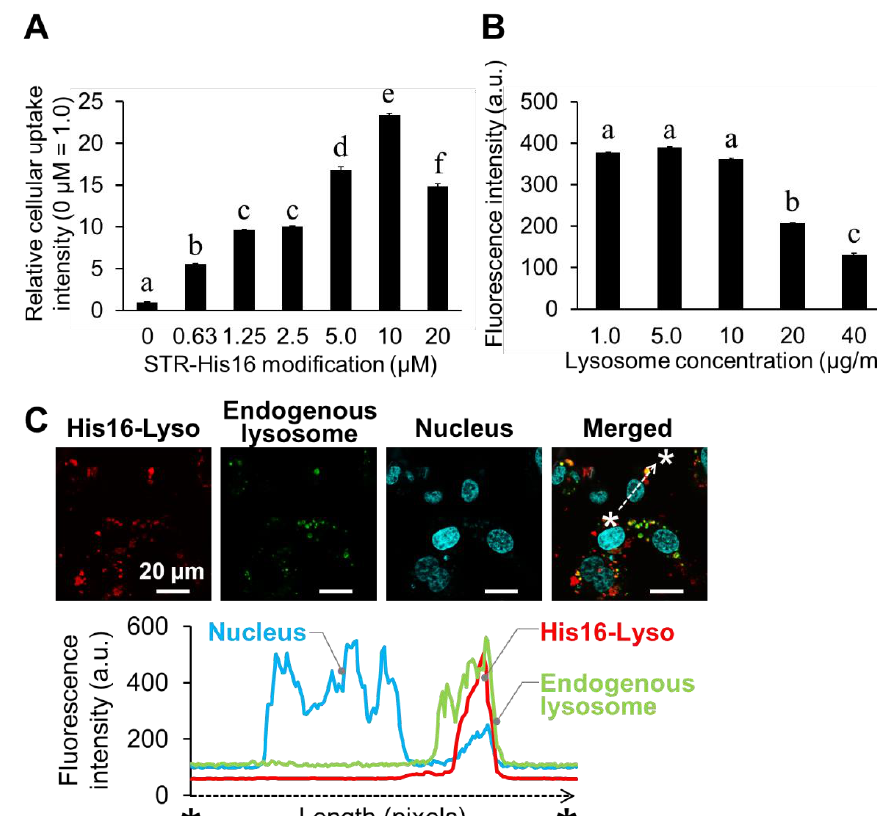
Figure 3. Model experiment for ORT using human fibrosarcoma HT1080 cells. ( A ) The optimal stearyl (STR)-His16 modification ratio for cellular uptake of His16-Lyso was determined. His16-Lyso